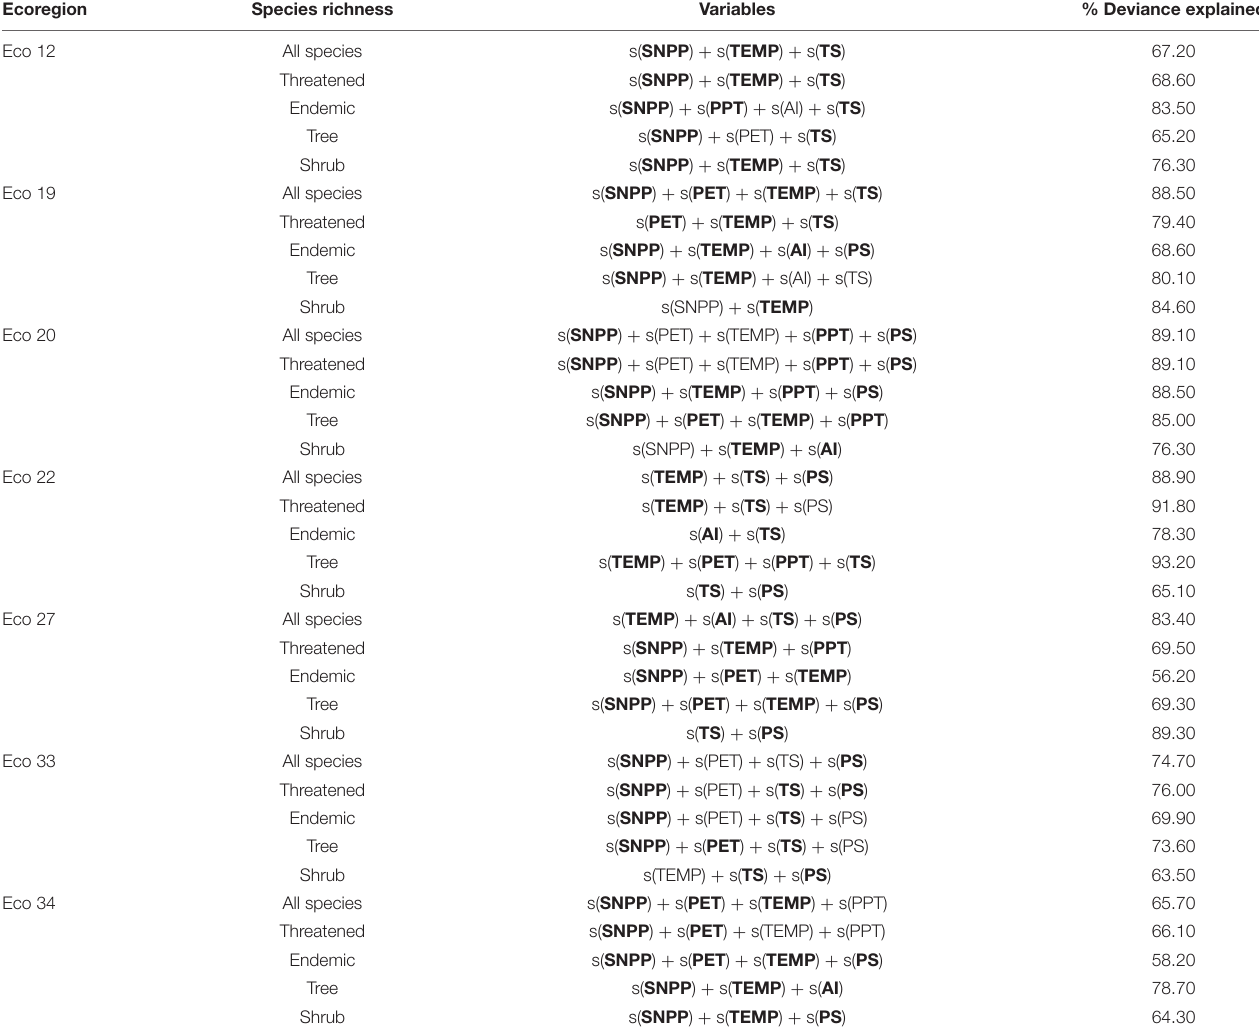
TABLE 2 | Percentage of deviance explained by the multivariate generalized additive model (GAM) and the best model that determine the richness patterns of gymnosperms in an ecoregion of China. Ecoregion Species richness Variables % Deviance explained Eco